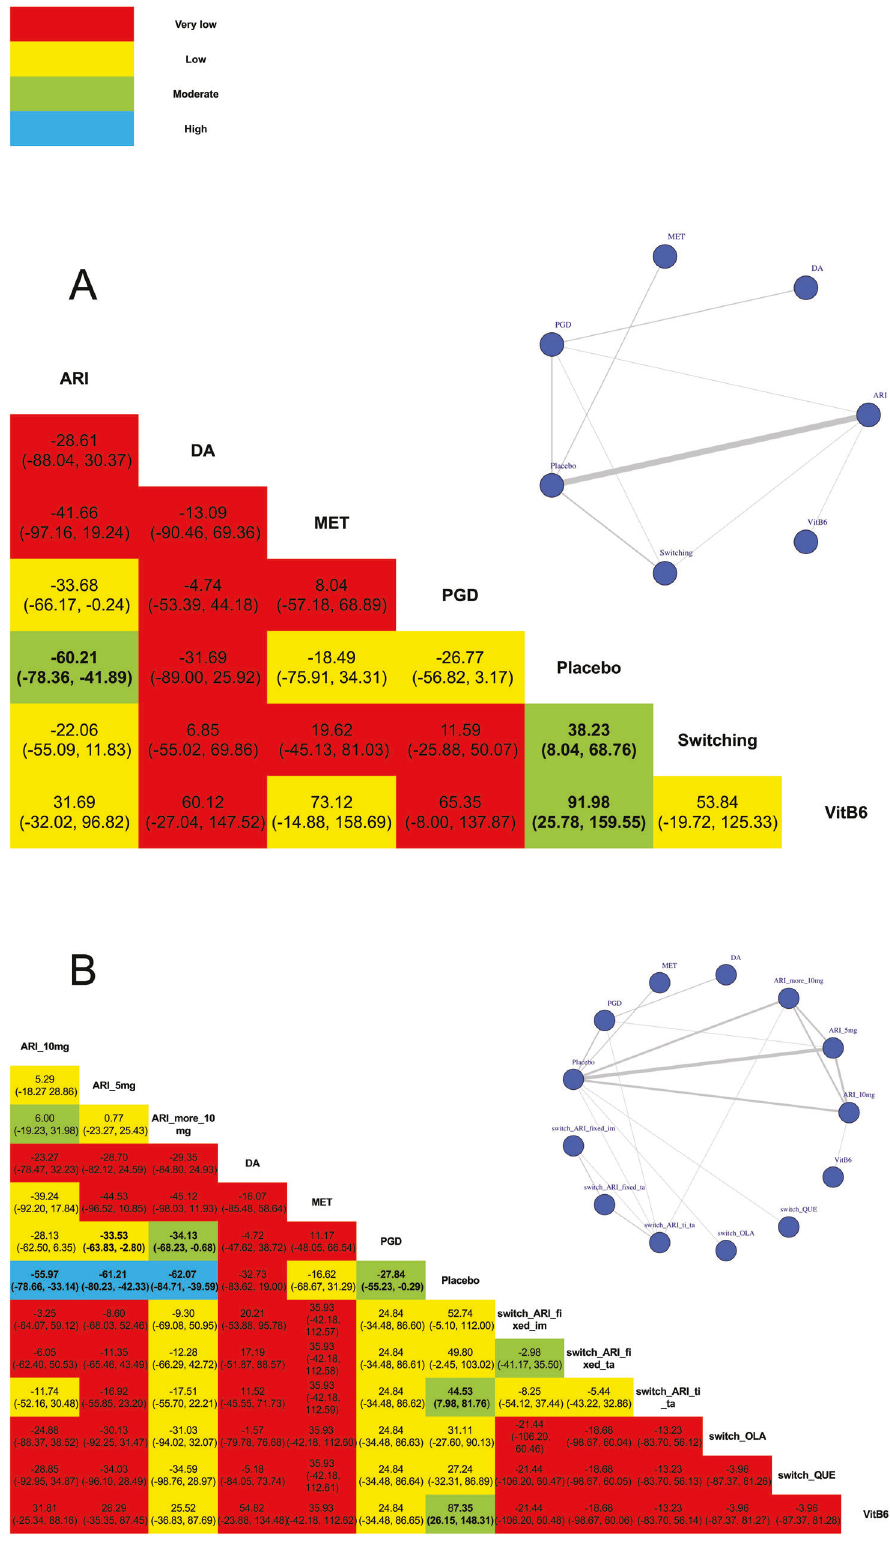
and 5 switching subgroups (witching to ARI with fi xed dosage and reducing the previous antipsychotic immediately (switch_ARI_ fi x- ed_im), switching to ARI with fi xed dosage and reducing the previous antipsychotic in tardation (switch_ARI_ fi